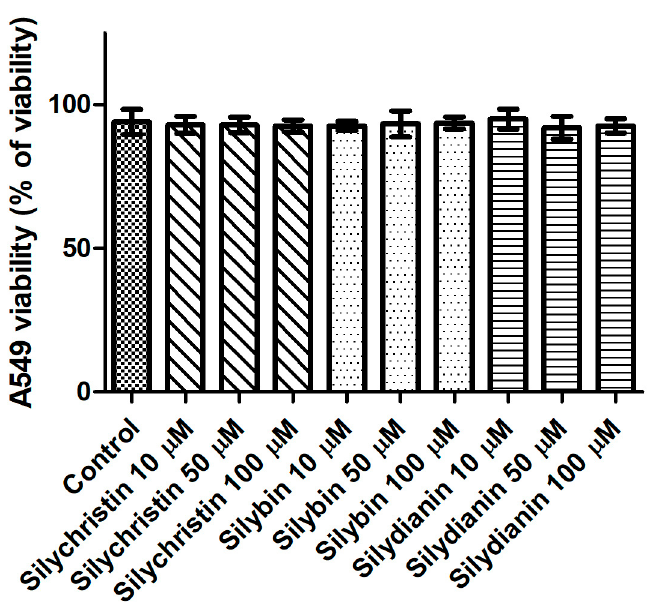
Figure 5. The effect of flavonolignans (silychristin, silybin and silydianin in concentrations of 10, 50 and 100 µM) on an A549 cell line, determined by trypan blue assay. The data represent the mean of 8 measurements.